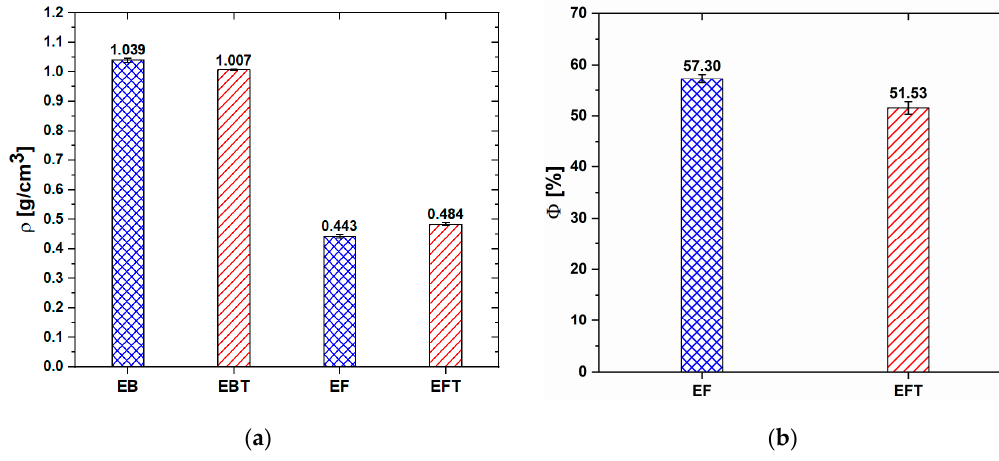
Figure 1. Density ( a ) and porosity ( b ) of the produced bulk and foam samples .